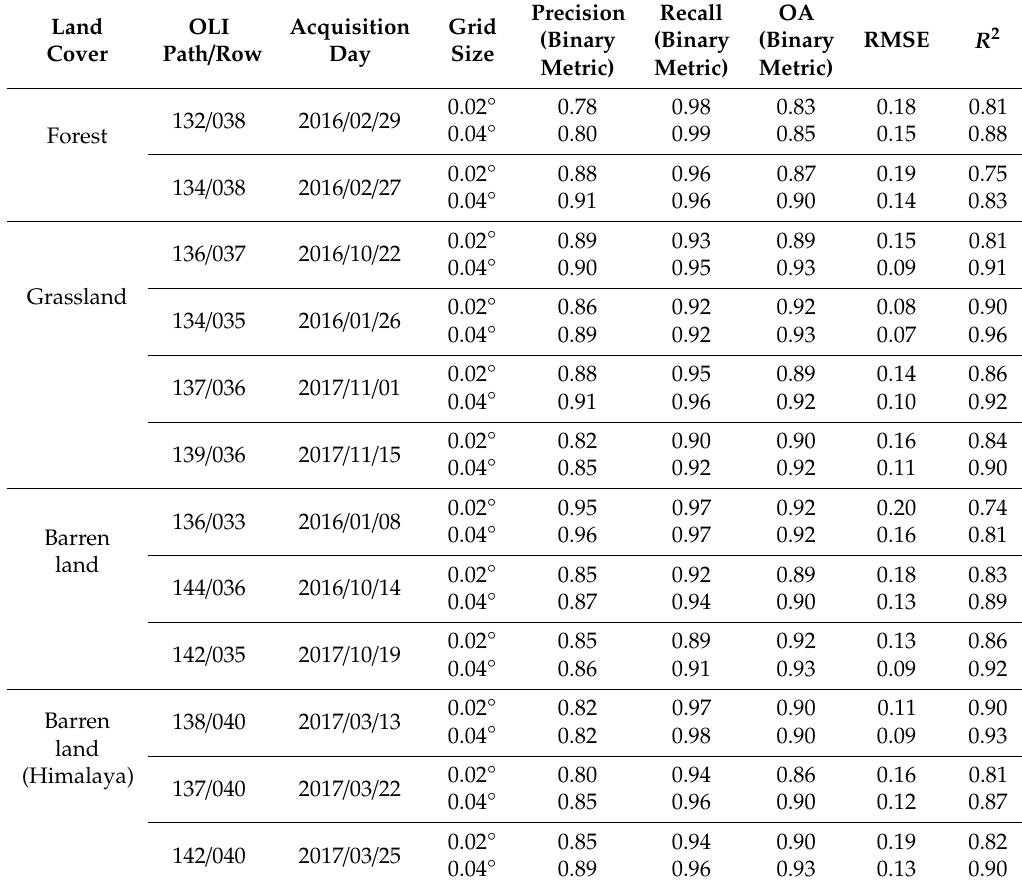
Table 3. Evaluation results of Himawari–8 instantaneous snow-covered area using Landsat–8 OLI